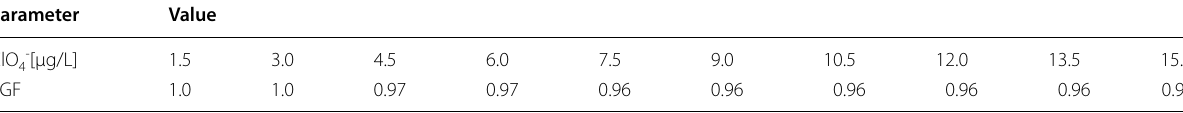
Table 1 Derived PGF for standard solutions Parameter Value ClO 4-